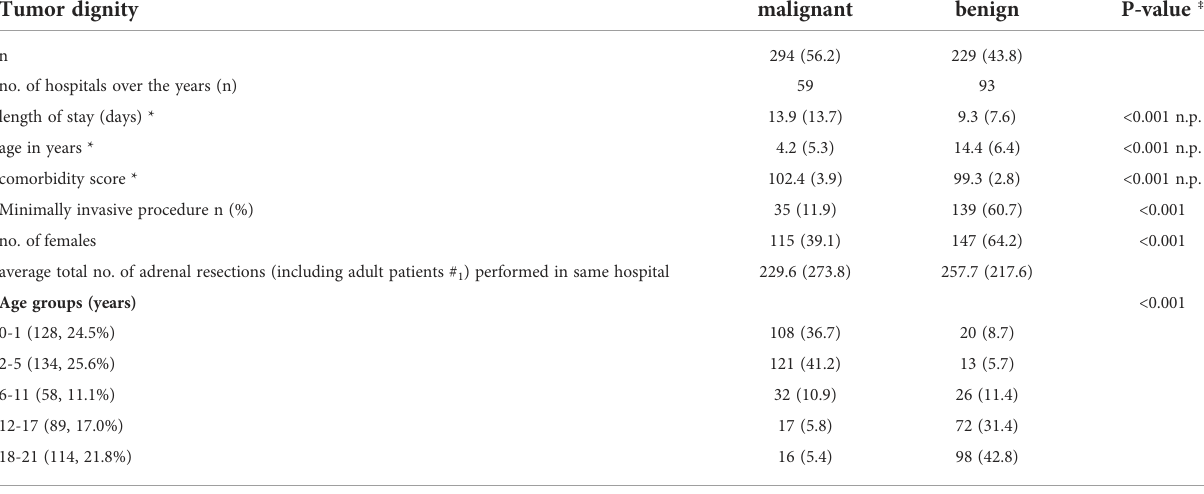
TABLE 2 Patients ≤ 21 years of age: patient characteristics by